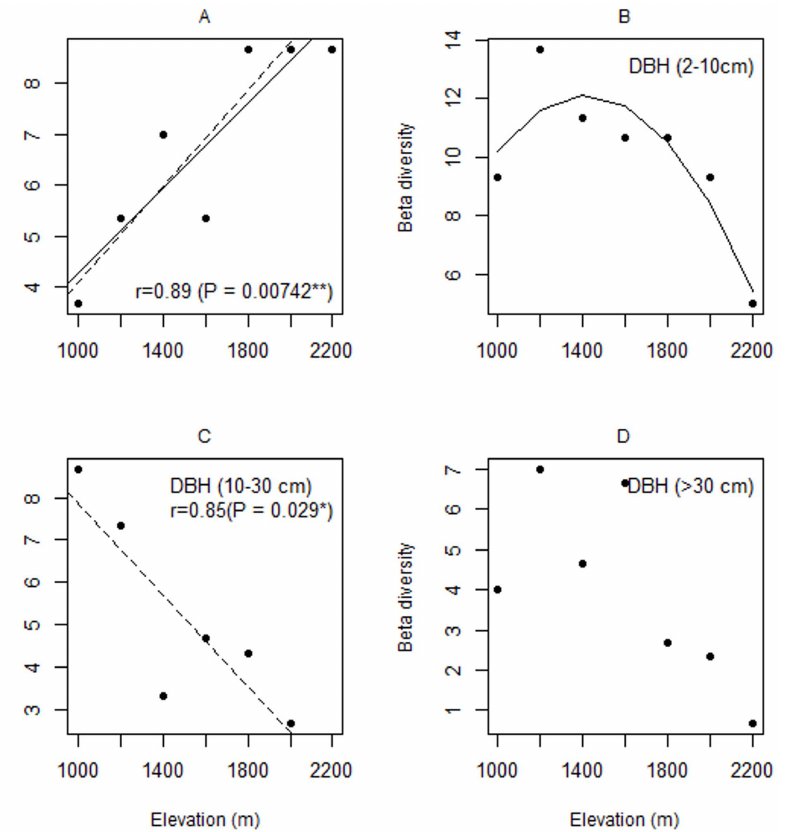
Figure 4. Relationships between elevation and beta-diversity (among plots with elevation stations) for different components of vegetation on Mount Rinjani, Indonesia. (A) ground-cover plants (y=6.92 + 2.06x), (B) understorey plants (y=10-4.2x-4.04x 2 , all stations 2200 m included), (C) subcanopy plants (y=4.62-2.32x), (D) canopy plants. Solid lines indicate relationships including all elevation stations and the dashed lines indicate the relationships when the station at 2200 m (fire-maintained grassland) was omitted. Only relationships that were significant ( p , 0.05) in univariate regression models are shown.